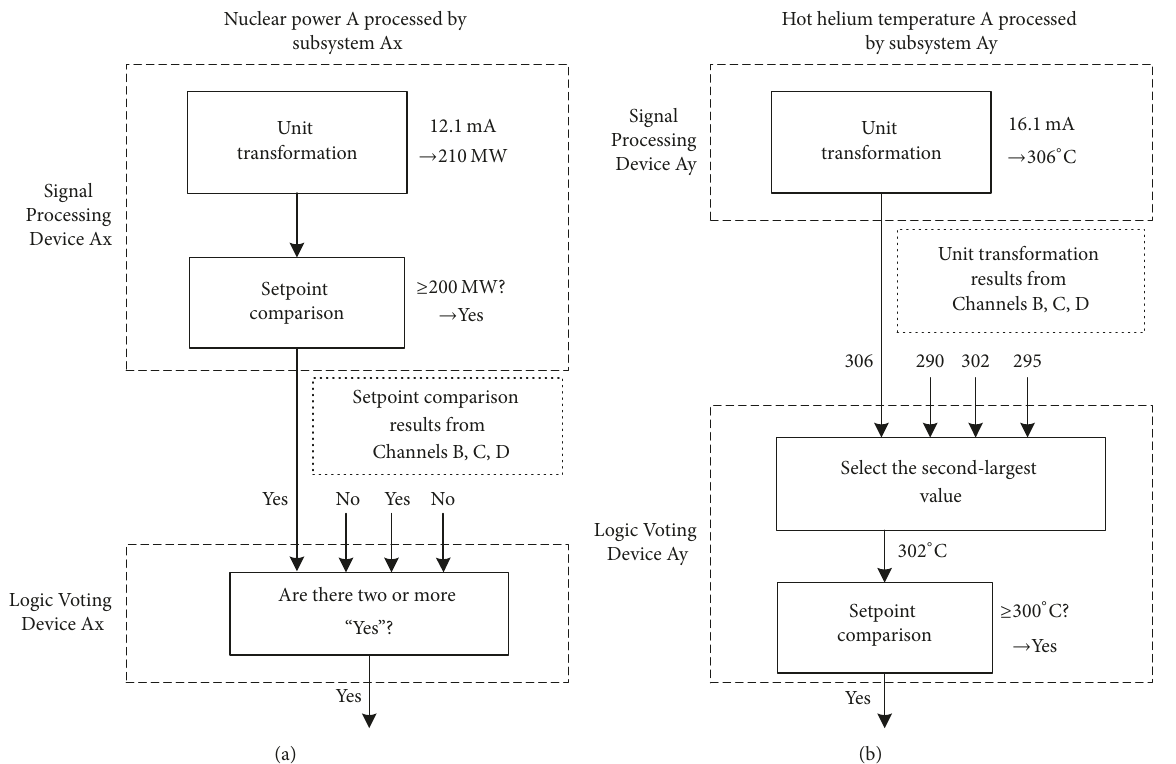
Figure 3: An example of diversity of 2/4 voting logic for (a) subsystem Ax and (b) subsystem Ay in Channel A.